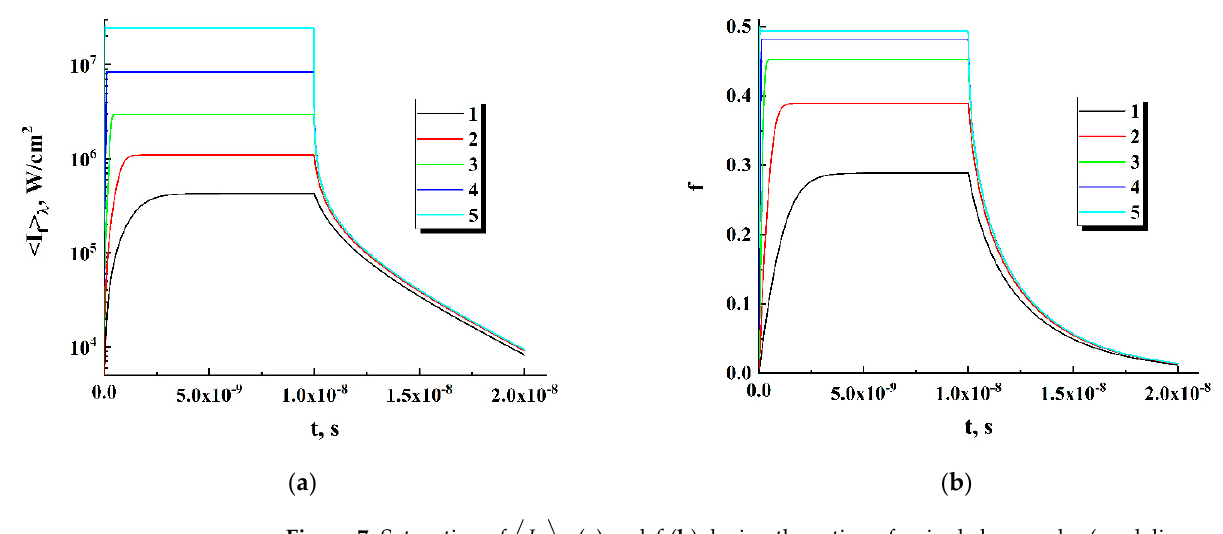
Figure 7. Saturation of ( a ) and f ( b ) during the action of a single laser pulse (modeling results). Pump intensity: 1×10 6 W/cm 2 (1); 3×10 6 W/cm 2 (2); 9×10 6 W/cm 2 (3); 2.7×10 7 W/cm 2 (4); 8.1×10 7 W/cm 2 (5).